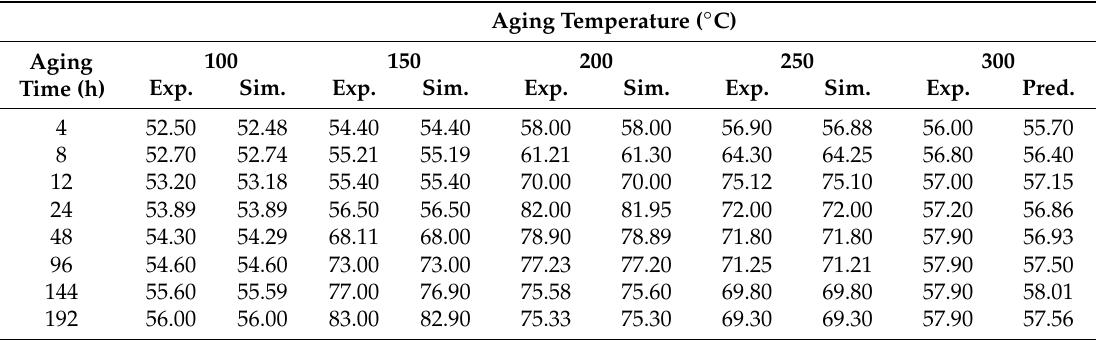
Table 3. Comparison between the ANN results and experimental